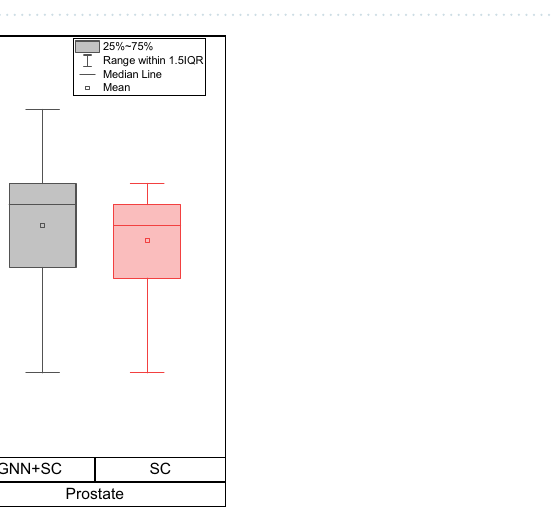
Figure 4. The proposed method is compared with the traditional method in the Prostate dataset. Figures ( a ) to ( d ) compare logistic regression model (LR), random (RF), Pearson correlation coefficient (Corr) and recursive feature elimination method (RFE).